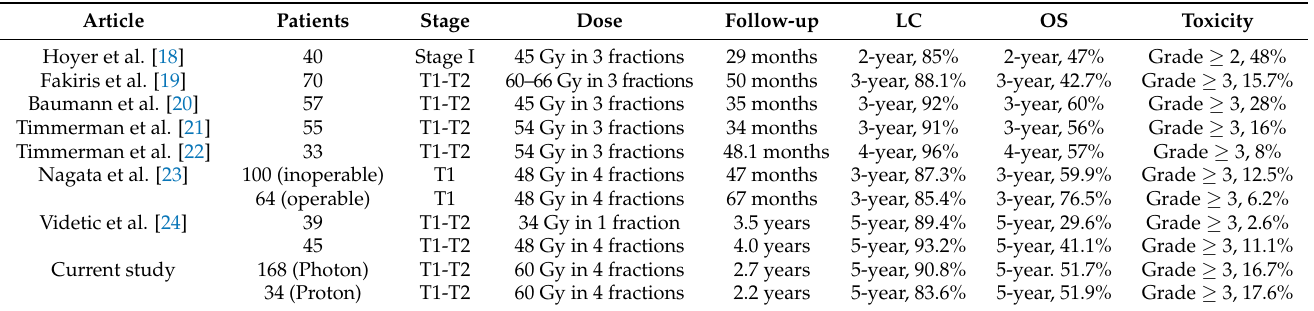
Table 5. Summary of prospective studies of SBRT for early-stage lung cancer, along with the cur- rent